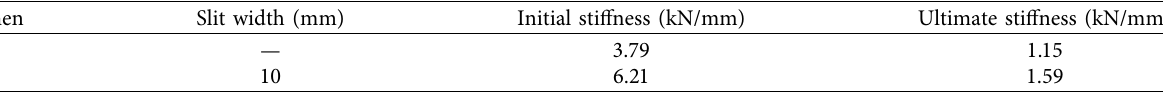
Table 3: Initial stiffness and ultimate stiffness.